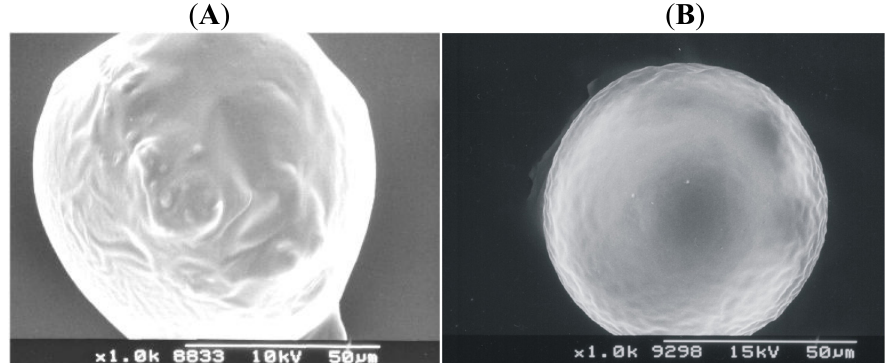
; X ; X ): ( A ) Drug-free sample 1 2 3 Cl 100% v/v; X = +1); ( C ) S9 ( − 1; 2 2 3